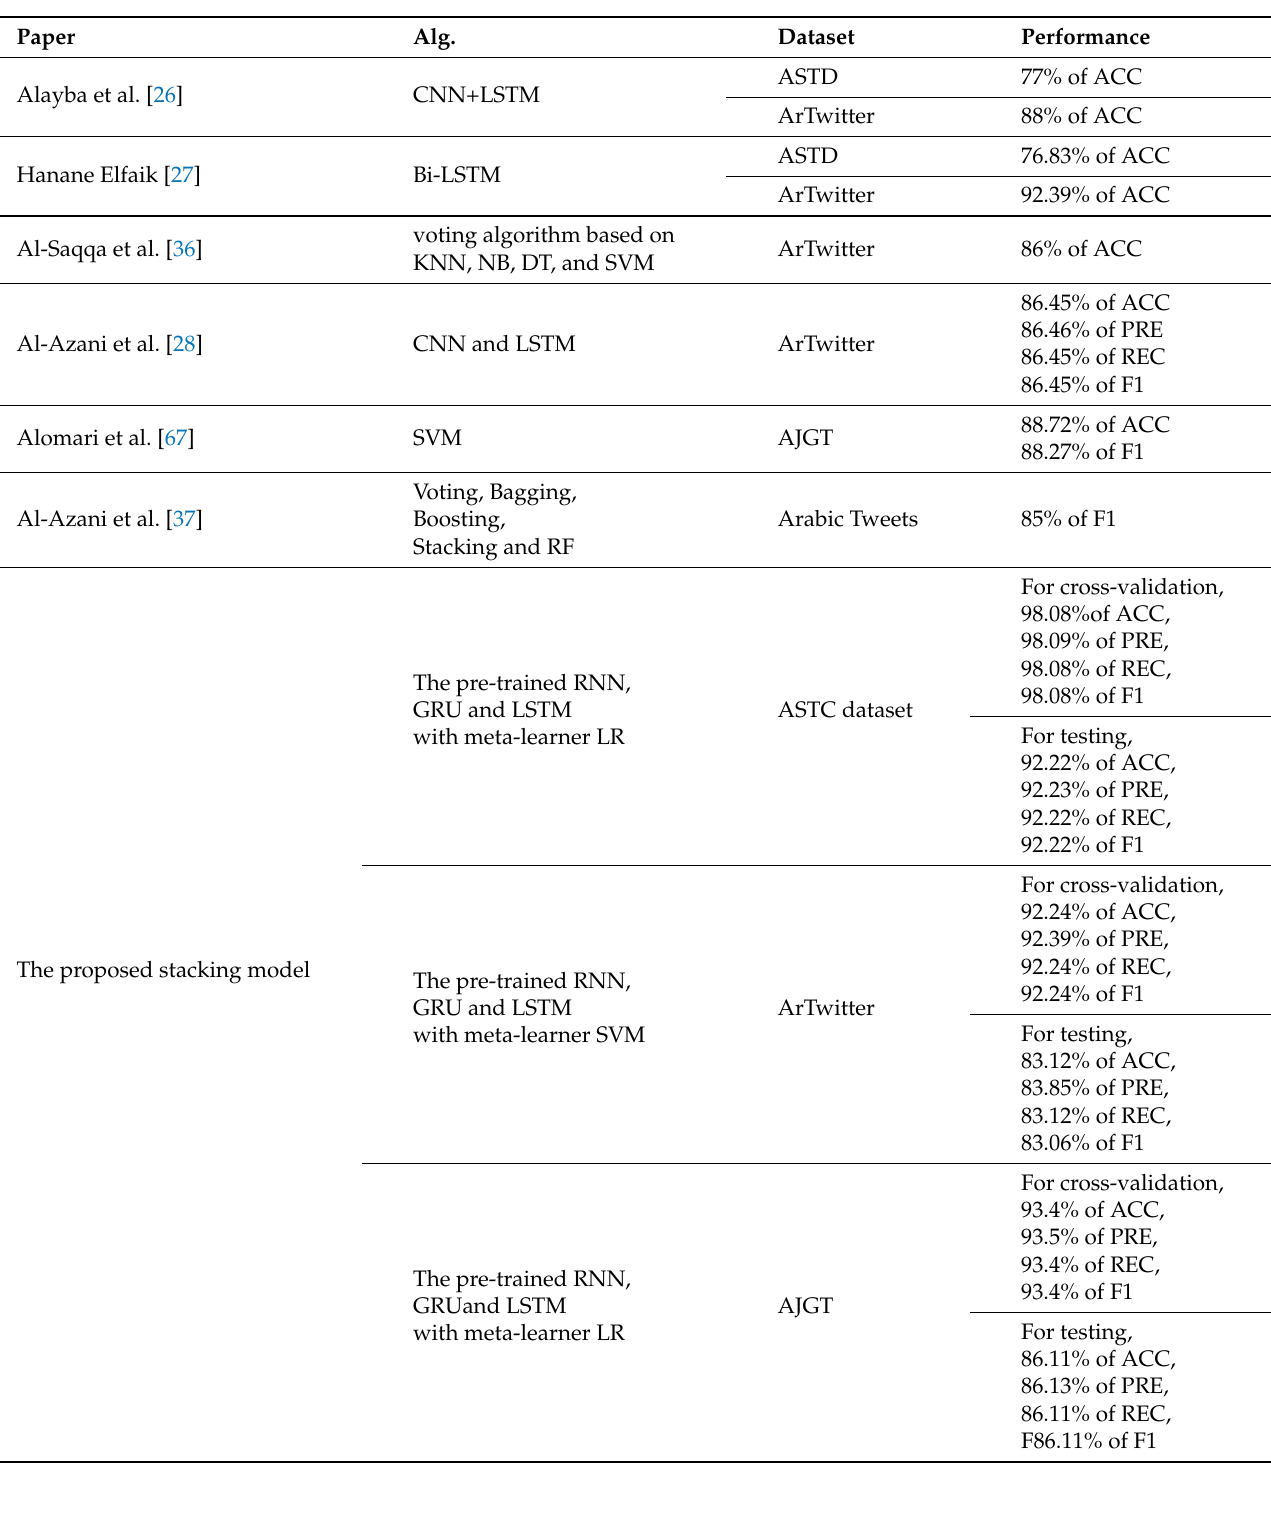
Table 5. The comparison of results to previous